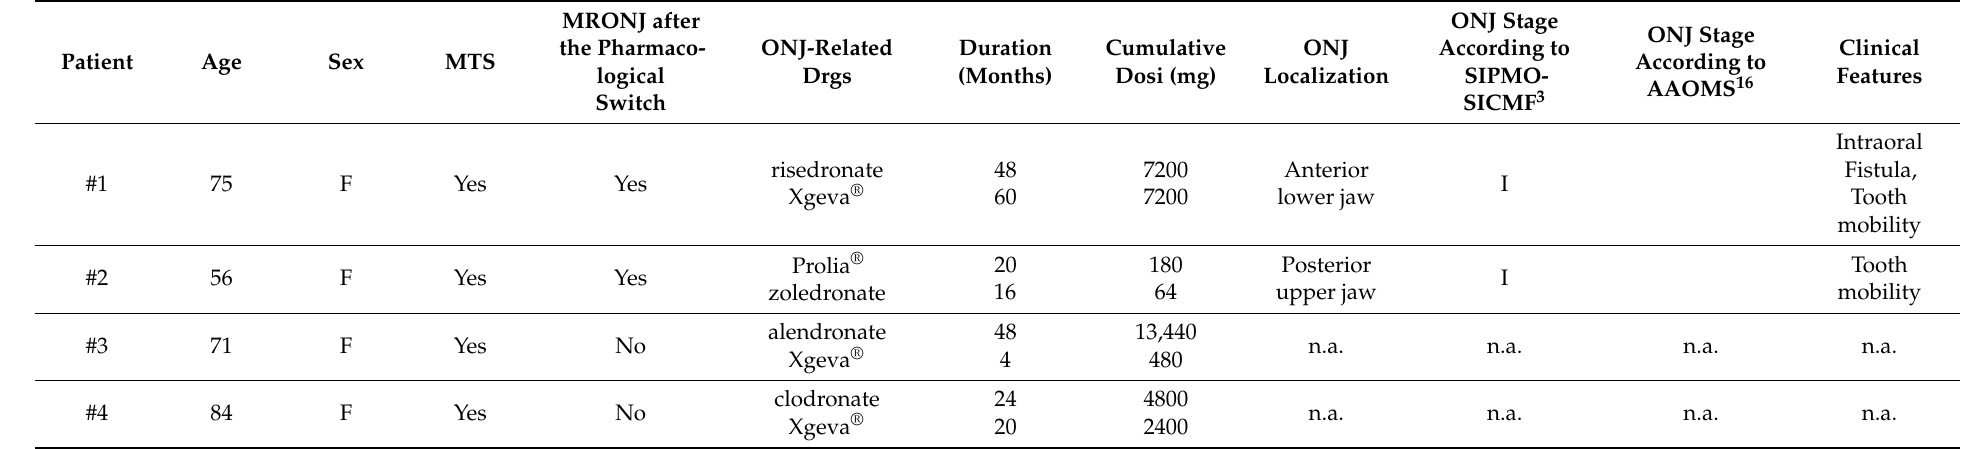
Table 3. Details of patients affected by breast cancer that switched BMAs therapy due to bone metastases development.